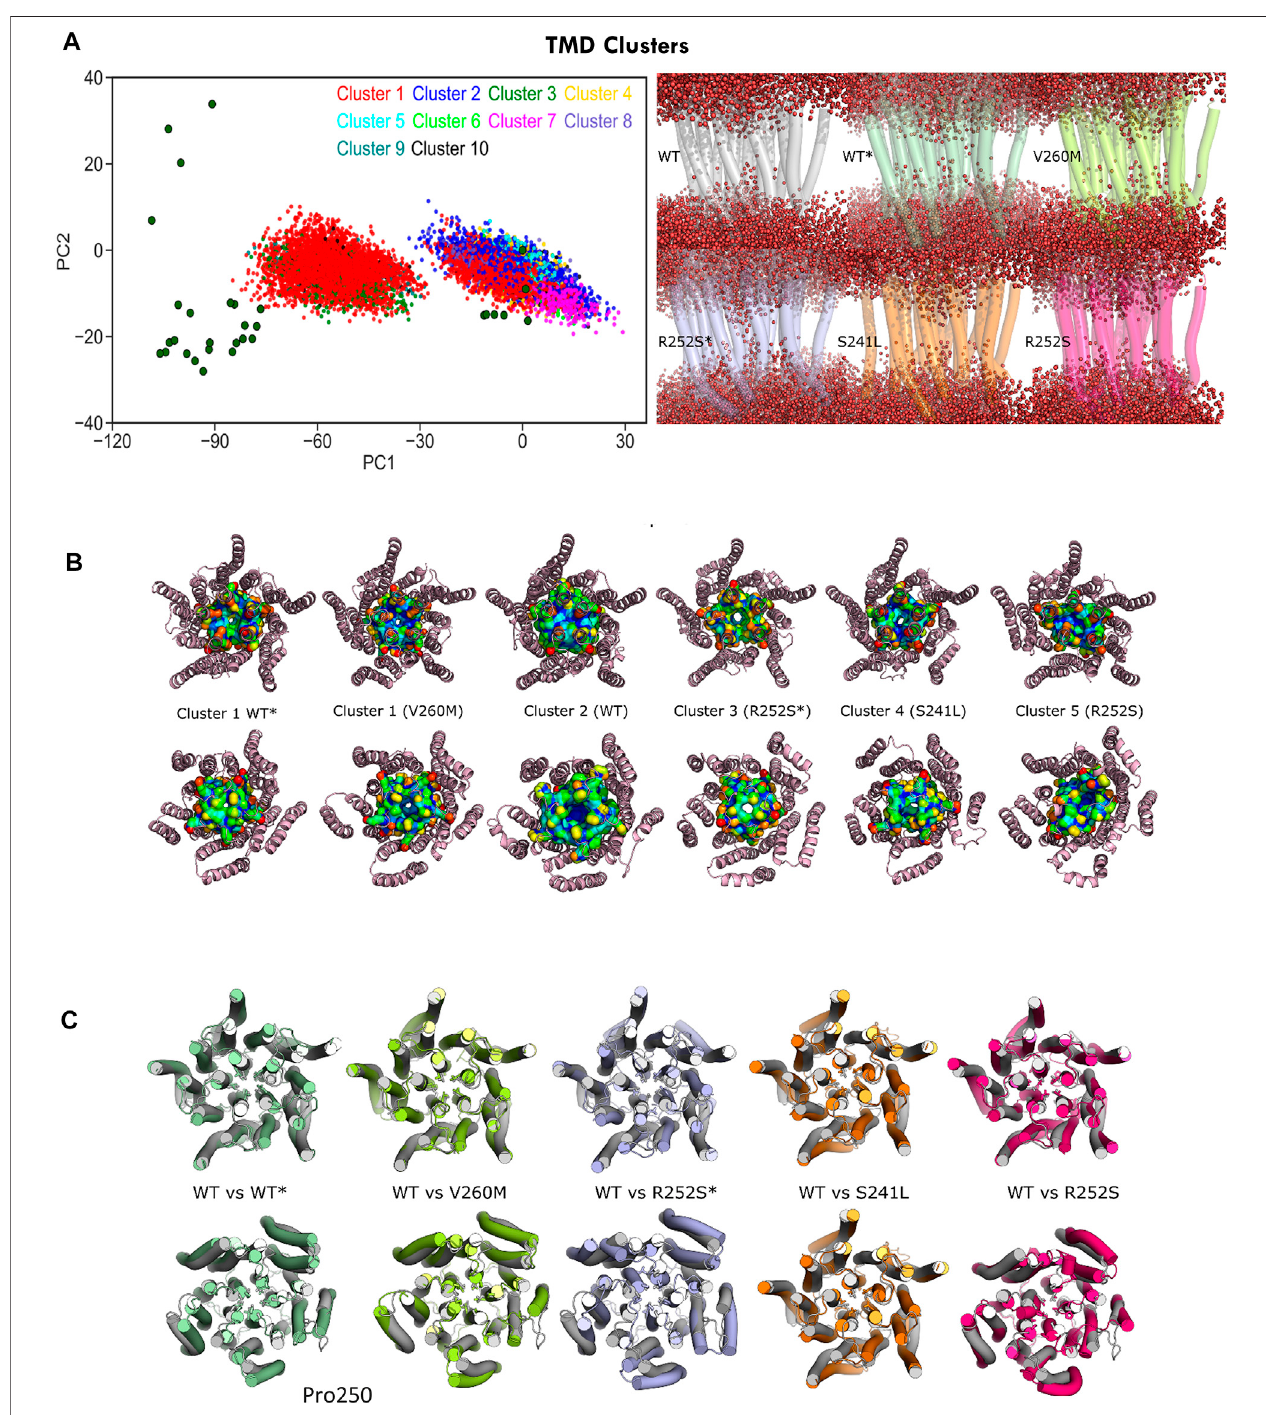
FIGURE 8 | C-alpha RMSD cluster analysis of the GlyR TMD. (A) Projections of major clusters onto PC1-2 space (left) and cluster representatives showing water permeation (right): top row , cluster 2 (WT) versus cluster 1 (WT* and V260M); bottom row, cluster 3 (R252S*), cluster 4 (S241L), and cluster 5 (R252S). (B) Top and bottomviewsofrepresentativeTMDclustersandM2helixresiduesshownwithsurfacerepresentation.Notethesimilarityoftheopenstatefrom5VDHinWTsimulations (WT*) versus the V260M initiated from 5CFB (V260M). (C) Top and bottom views of representative TMD clusters, with side chains for pore gates (Leu261, Pro250) shown as licorice. See Supplementary Table S4 .